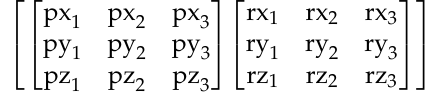
Figure 3. Our pose regression model. We modify the existing Conv2D layer to incorporate the position and orientation data in different depths of our input matrix. Convolutional layers generate feature maps that separately have the position and orientation information. Without this consideration, one datatype could dominate the other after convolution, resulting in the loss of one of the features. Since our architecture has the position and orientation data in different depths, our convolutional layer keeps the position and orientation features rather than one fading away. Position and orientation data in our architecture works similarly to the red, green, and blue channels in the conventional Conv2D layer for image-related problems. The input matrix components are as depicted in Equation (1). Given the 18 input values, which are the position and orientation values of j 1 , j 2 , and j 3 , our pose regression model estimates the position values for the target joints j 4 , j 5 , j 6 , j 7 , j 8, and j 9 . In the input matrices, the width is the joint index of the head, left-hand, and right-hand joints, the height is the values along x -, y -, and z -axes, respectively, and the depth is the position and orientation data.